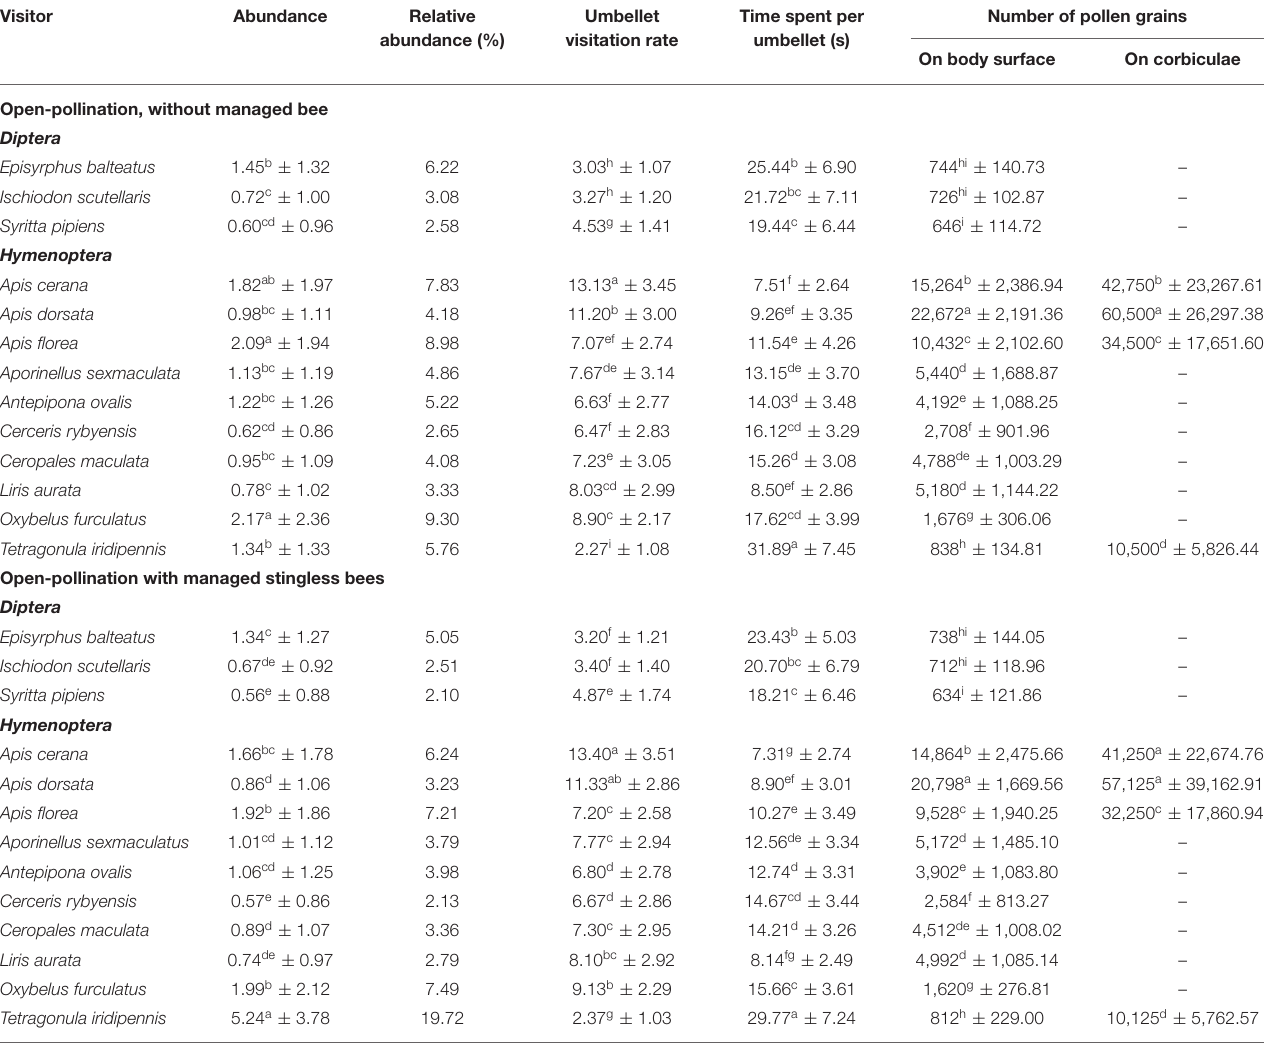
TABLE 4 | Abundance (number/m 2 area/5min), relative abundance, umbellet visitation rate, amount of time spent per umbellet, and number of pollen grains carried by the dominant floral